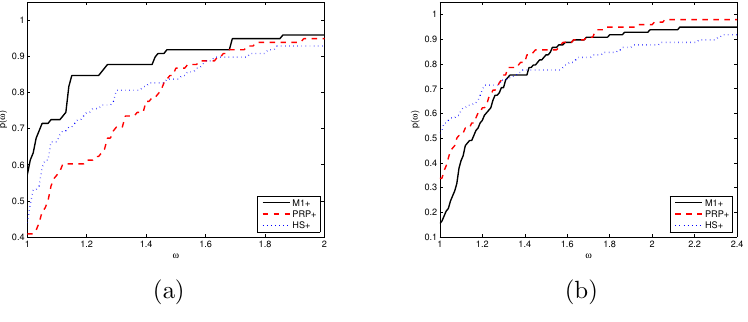
Figure 3. (a) Total number of function and gradient evaluations and (b) the CPU time performance profiles for M1+, PRP+ and